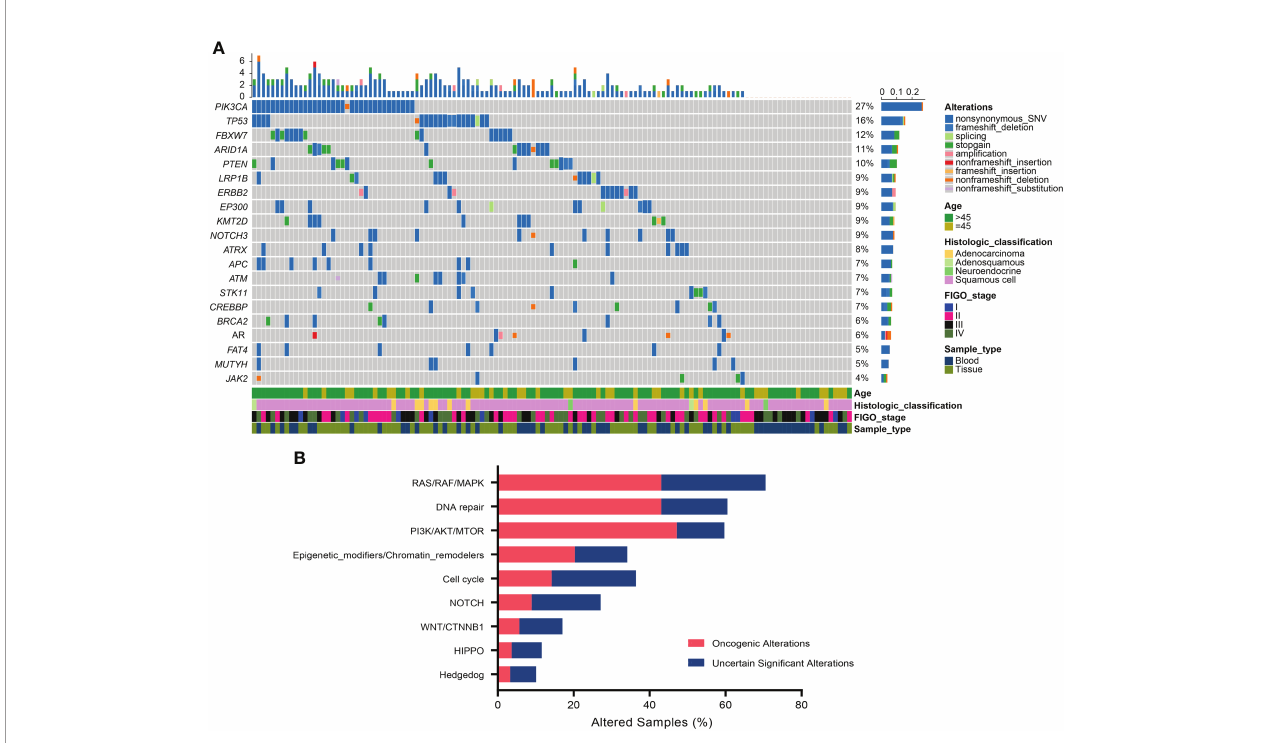
FIGURE 1 | Somatic alterations in Chinese cervical cancer patients. (A) Oncoprint of the top 20 frequently altered genes in 129 cervical cancer patients. (B) The distribution of most recurrent altered signaling pathways in the Chinese cervical